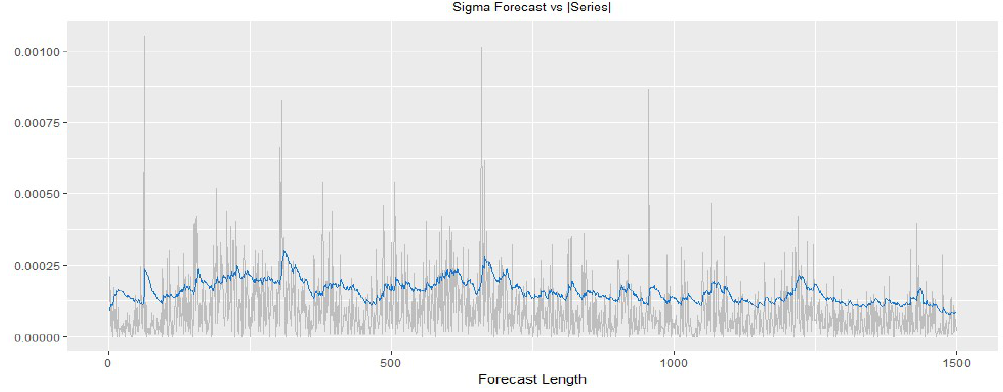
Figure 7. Sigma forecast plot.